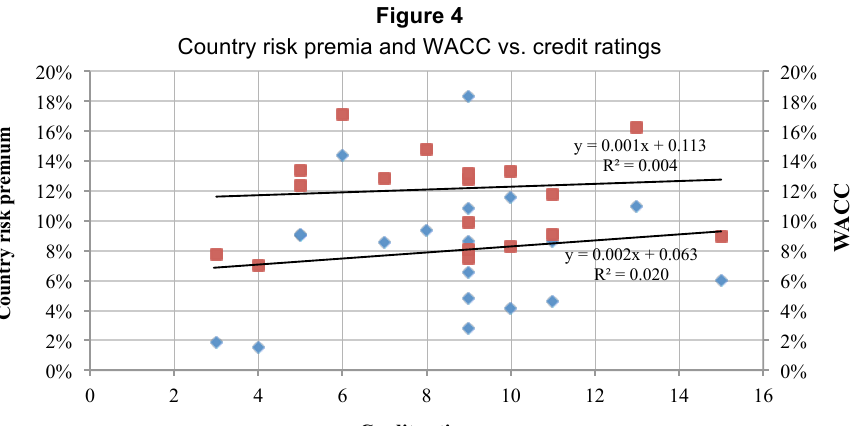
Country risk premia and WACC vs. credit